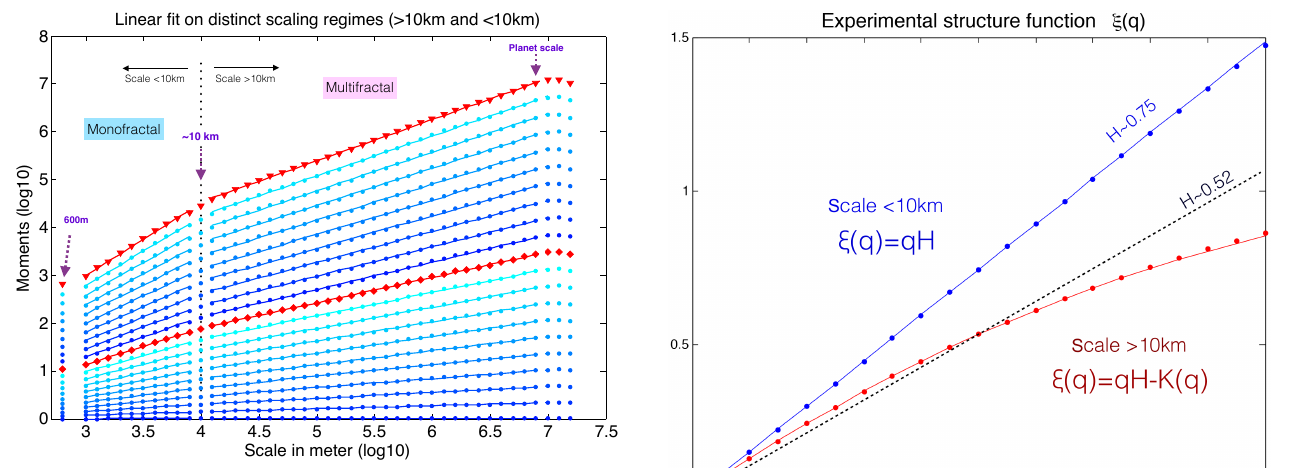
Figure 2. Linear fit on the two different scaling regimes (below and above 10km) for every 21 statistical moments from 0.1 to 2. The color code is the same as in Fig. 1. Quantities on that plot are scaled according to the moment scaling function ξ(q) .